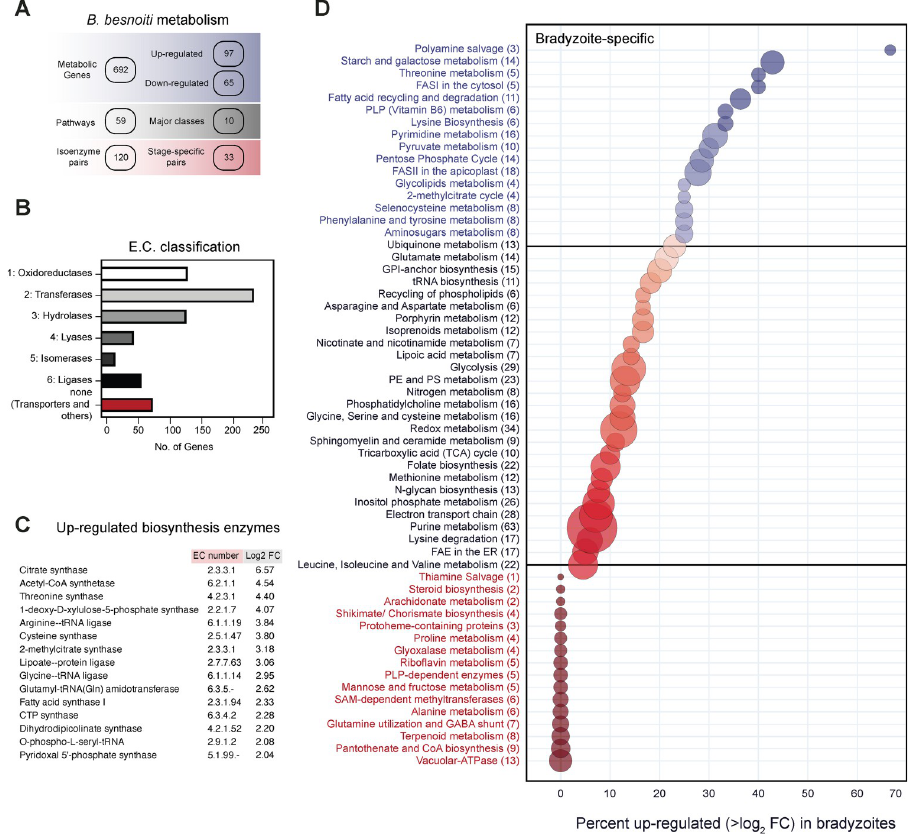
Fig 8. Metabolic pathways of B . besnoiti . (A) Overview and classification of metabolic genes: number of annotated genes, pathways, and isoenzymes in B . besnoiti . Up- and downregulated genes have a relative fold-change > 4 (log 2 > | 2|). Stage-specific isoenzymes are pairs that display upregulation only in one stage of the parasite (bradyzoites or tachyzoites; see also Tab E in S8 Table). (B) E.C. classification of all enzymes found in the B . besnoiti genome. Transferases are the most common class of enzymes, followed by transporters and enzymes with an unknown function (see also Tab F in S8 Table). (C) List of up-regulated genes encoding biosynthesis enzymes by the cyst-forming B . besnoiti bradyzoites. These enzymes are part of diverse metabolic pathways, including several tRNA-synthetases. (D) The 59 curated metabolic pathways identified in B . besnoiti , ordered by percentage of genes upregulated in the bradyzoite stage. Bubble size represents the number of genes (in brackets) in each pathway. Eighteen pathways have more than 25 percent of their genes upregulated in the bradyzoite stage.